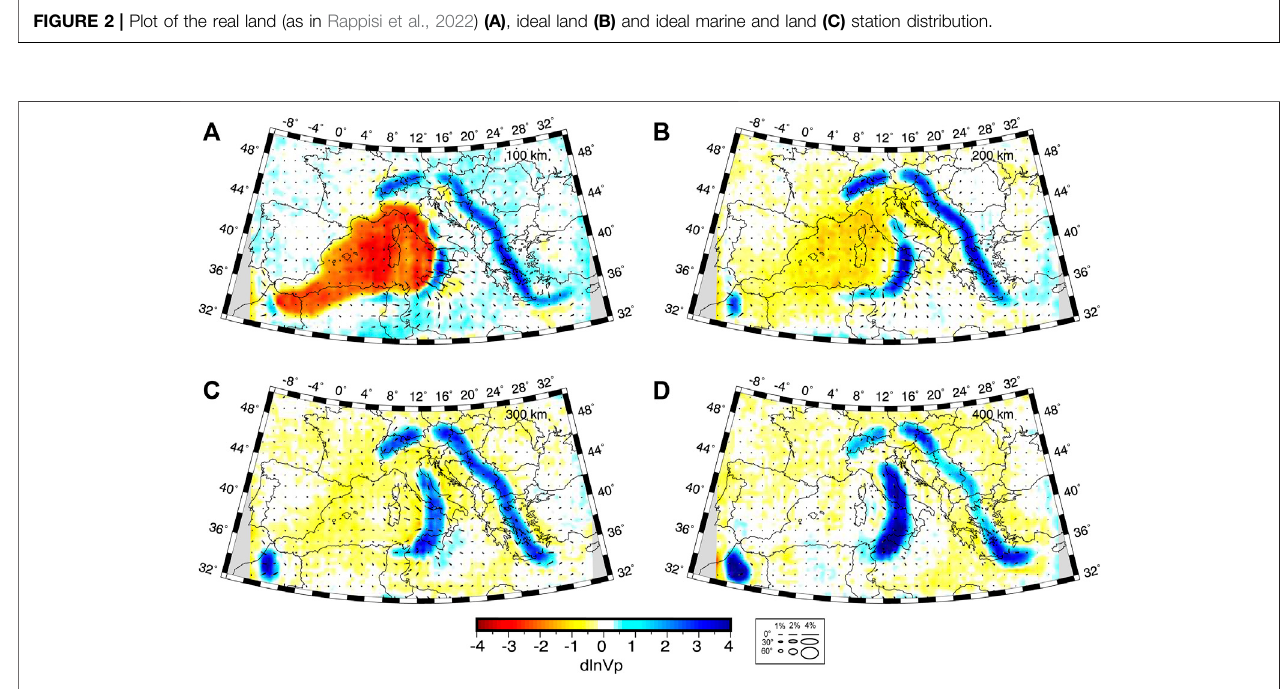
FIGURE3| Depthslicesat (A) 100km, (B) 200km, (C) 300Kmand (D) 400kmdepth.Isotropicrestorationsynthetictest.Anisotropicinversion ofpurelyisotropic synthetic data calculated through our model CWM, i.e., non taking into account the anisotropic patterns. While no anisotropic structures have been considered when performing the forward problem, the inversion does introduce some anisotropic perturbations. Anisotropy is represented by ellipse symbols where the major axis of the ellipse parallels the fast-direction and the minor axis scales linearly with the symmetry axis dip into the view plane such that fabrics parallel and normal to the cross- sections plot as lines and circles, respectively. Anisotropic perturbations were restricted to the upper 400 km. See legend. Areas of poor data coverage are masked in grey.